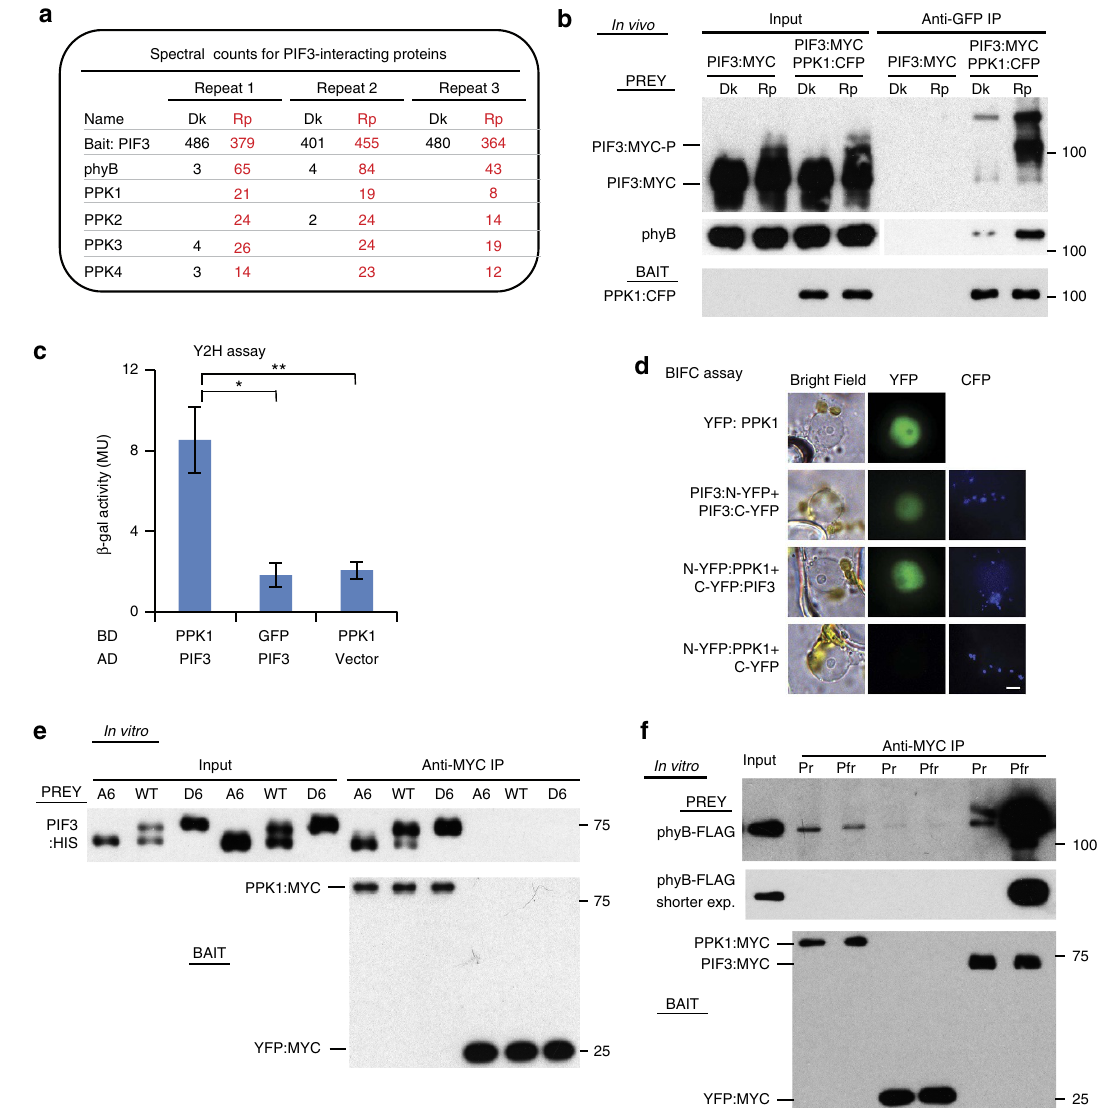
Figure 1 | In vivo light promotes the interaction of PPKs with PIF3 and phyB. ( a ) PIF3-interacting proteins detected by co-immunoprecipitation (co-IP) from cell extracts and subsequent mass spectrometric analysis. Spectral counts from three biological replicates of dark (Dk)-grown and red-light-pulse (Rp)-treated seedlings, respectively. ( b ) In vivo light-induced interaction of PPK1 with PIF3 and phyB detected by co-IP and subsequent immunoblot analysis. Protein extracts from Dk- or Rp-treated seedlings of the indicated genotypes were immunoprecipitated with anti-GFP antibodies, to pull down CFP-tagged PPK1 as bait, and the immunoblot was probed with either anti-MYC antibody (top, Prey), anti-phyB antibody (middle, Prey) or anti-GFP antibody (bottom, Bait) to detect PIF3:MYC, phyB and PPK1:CFP, respectively. ( c ) PIF3 and PPK1 interact in yeast-2-hybrid (Y2H) assays. LexA-DNA-binding-domain-fused PPK1 or GFP were used as bait, and B42 activation-domain-fused PIF3 or empty vector were used as prey in a standard Y2H configuration. Error bars represent standard error (s.e.) from three biological replicates. * P o 0.05, ** P o 0.01 (Student’s t -test). ( d ) PIF3 and PPK1 interact in transient-transfection, Bimolecular Fluorescence Complementation (BiFC) assays. Light-grown Nicotiana benthamiana leaves were transfected with the constructs indicated and then exposed to 10min FR light and incubated in darkness for 72h before microscopic analysis. Constructs used: YFP:PPK1, yellow fluorescent protein (YFP) fused to PPK1 protein; N-YFP and C-YFP, N- and C-terminal domains of split mVenus210 fluorescent protein, respectively, fused (or not) to PIF3 or PPK1 proteins. All split-Venus constructs also carried the mTq2 Golgi-localized marker as a positive control for transfection. Imaging configuration: Bright field, YFP emission filter; CFP (Cyan Fluorescent Protein) emission filter. Quantification of nuclei displaying split-Venus fluorescence shown in Supplementary Fig. 2a. Scale bar, 5 m m. ( e ) Interaction of in vitro -synthesized recombinant PPK1 and PIF3 proteins detected by co-IP assays as described in b , except that the PPK1 bait was tagged with MYC (PPK1:MYC), and immunoprecipitated with anti-MYC antibodies, and the PIF3 prey was tagged with HIS (PIF3:HIS). YFP:MYC bait was used as a negative control. The immunoblot was probed with either anti- HIS antibody (top, Prey) or anti-MYC antibody (bottom, Bait). WT, wild-type PIF3 sequence; A6, PIF3 variant with phospho-dead mutations; D6, PIF3 variant with phosphomimic mutations 4,17 . ( f ) In vitro -synthesized, recombinant PPK1 and phyB interact as detected by co-IP assays as described in b , except that the PPK1 bait was tagged with MYC (PPK1:MYC) and immunoprecipitated with anti-MYC antibodies, and the phyB prey was tagged with FLAG (phyB:FLAG). PIF3:MYC was used as a positive-control bait for light-induced phyB activation and YFP:MYC as a negative control. The immunoblot was probed with either anti-FLAG antibody (top and middle, Prey), or anti-MYC antibody (bottom, Bait). Pfr and Pr, samples were irradiated with R light only, or R followed by FR, respectively, before